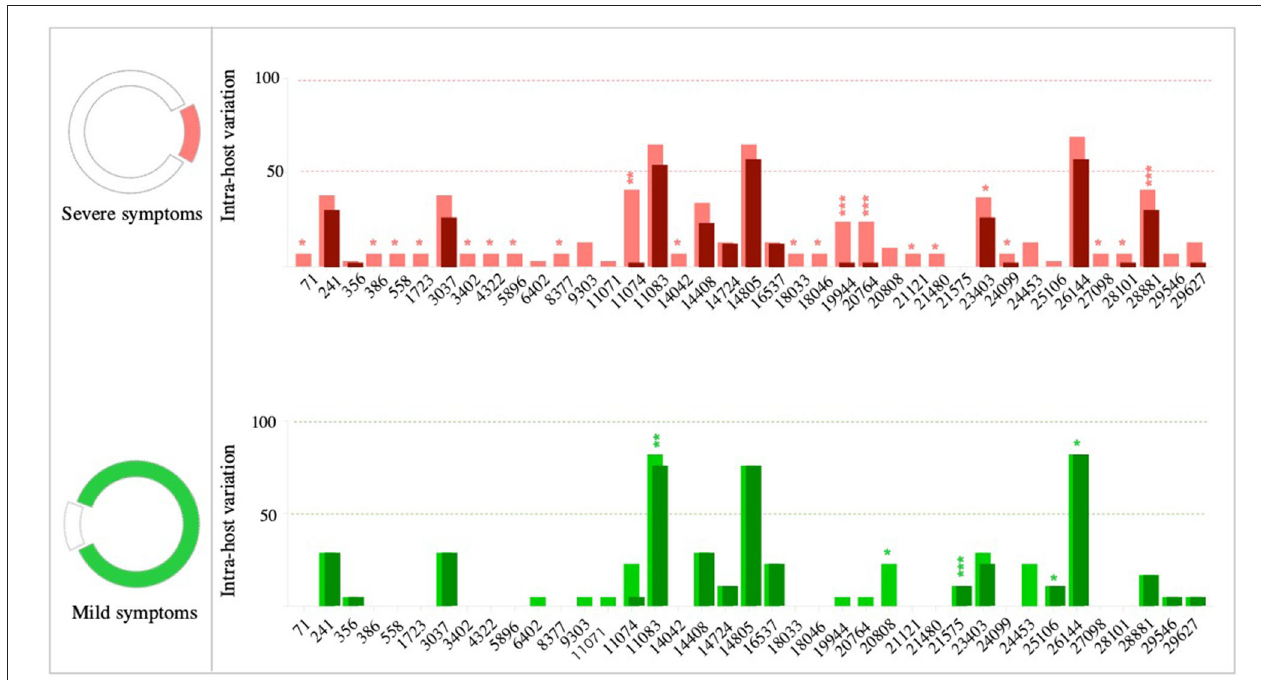
FIGURE 4 | Comparison of variant prevalence in mild cases (green) and severe cases (red). Colored parts of the circles (on the left) represent variants seen in more than one patient. Only variants found in more than one patient were used to generate bar charts. Bar charts demonstrate the prevalence of each variant in patients within each group (severe vs. mild). Bars with darker colors demonstrate variants detected at the consensus sequence level. P -values are indicated as follows: **** p < 0.0001, *** p < 0.001, ** p < 0.01, and * p <